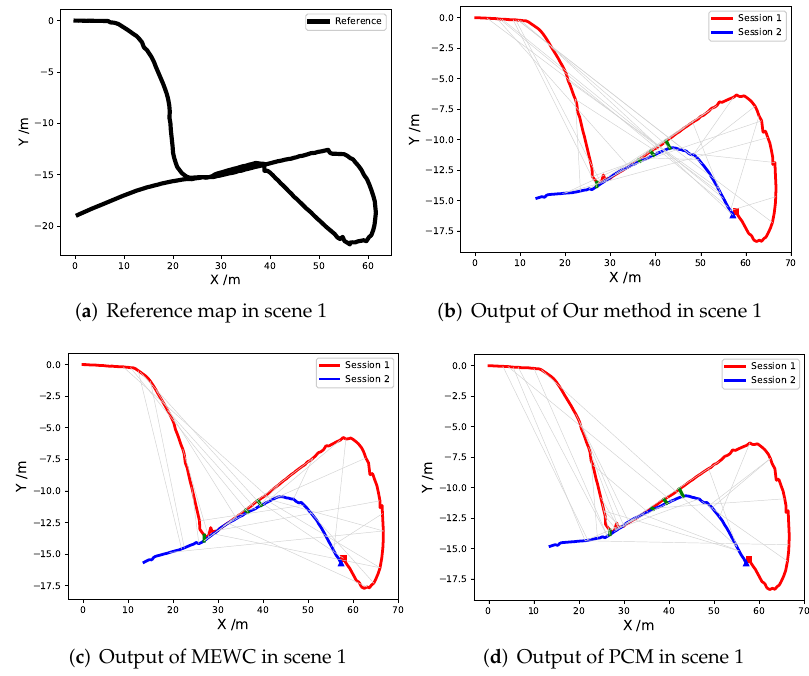
Figure 9. The fused global map corresponding to scene 1 shown in Figure 8a. The red square and blue triangle represent the end position of session 1 and the start position of the trajectory of session 2, respectively. Correctly accepted inlier constraints are green, disabled outliers in